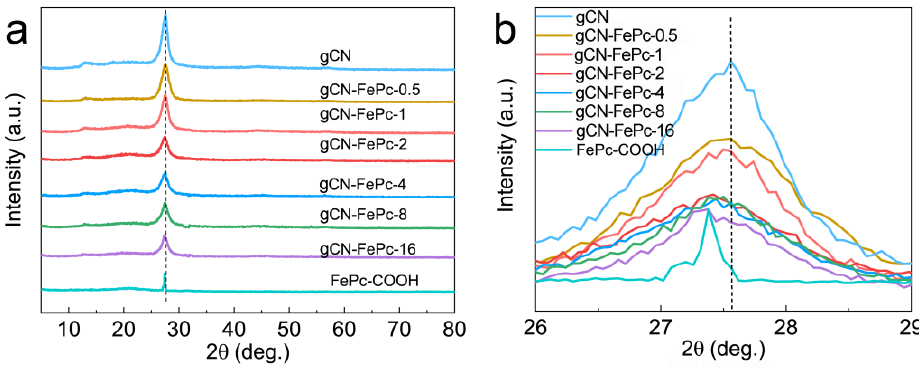
Figure 1. SEM and TEM images of gCN ( a , b ) and gCN-FePc-1 ( c , d ).